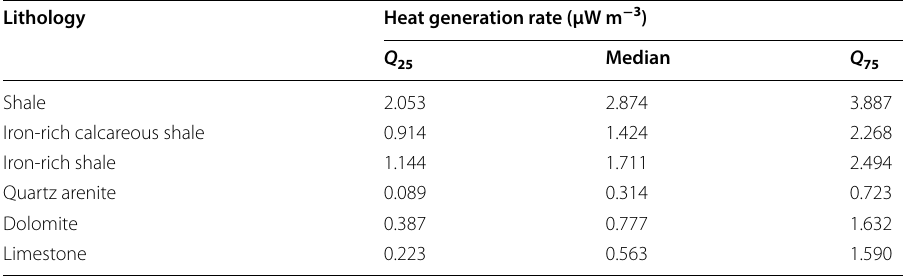
Q 25 and Q 75 are the first and third quartiles of samples analyzed